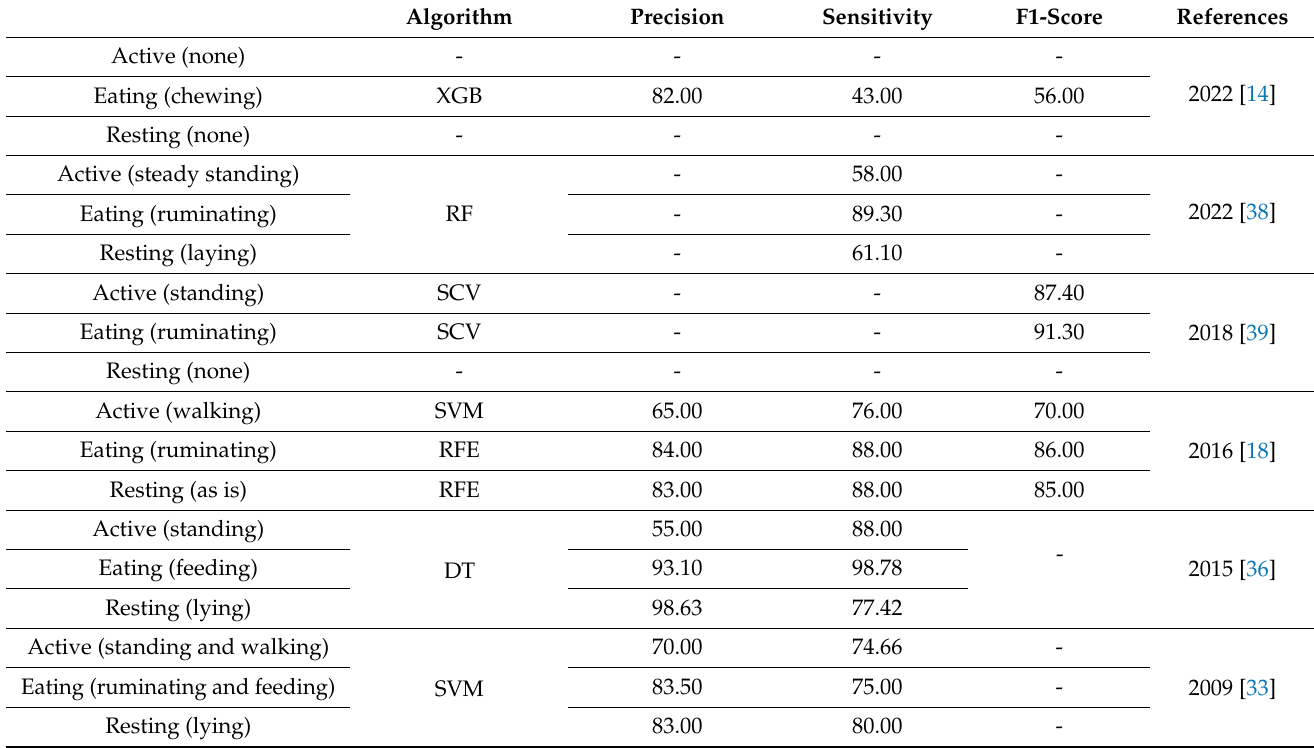
Table 4. Related works about classification performance using triaxial accelerometer in detecting cattle behaviors.